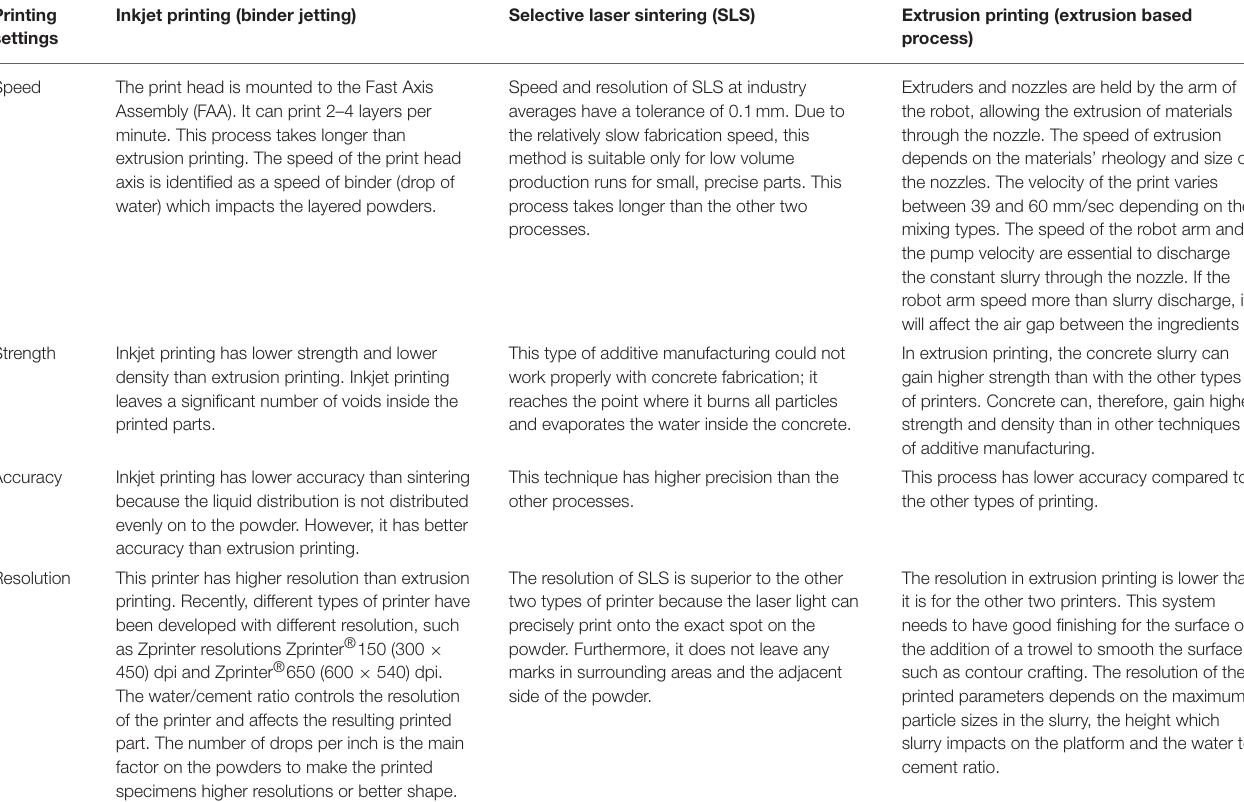
TABLE 5 | Explanation of settings of printing and printing methods. Printing